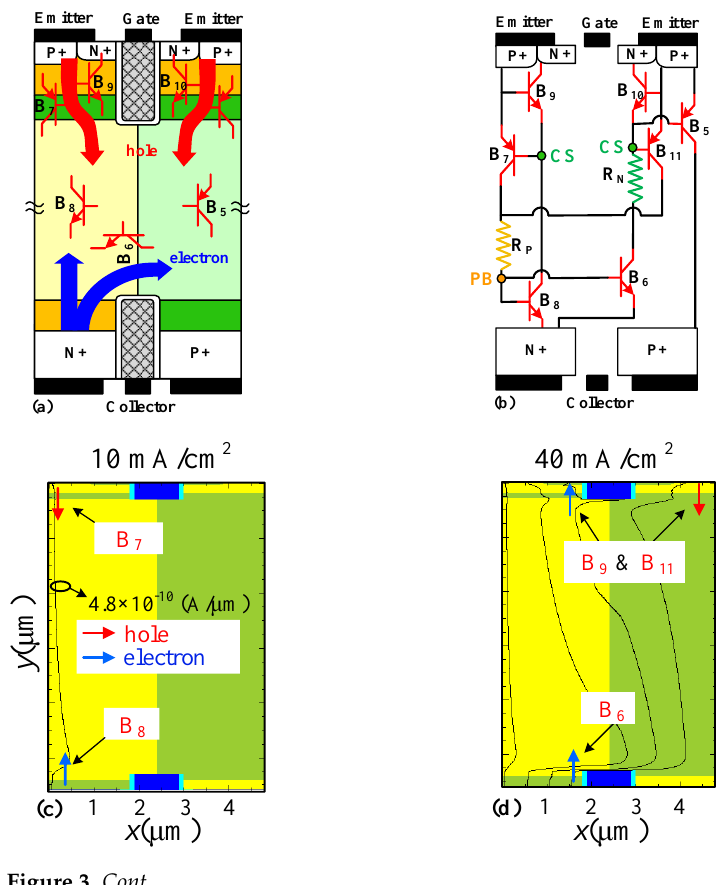
IGBT, the corresponding equivalent circuits, and the current distributions under different conduction current density. The parasitic Bipolar Junction Transistors (BJTs) are marked in Figures 3a and 4a.